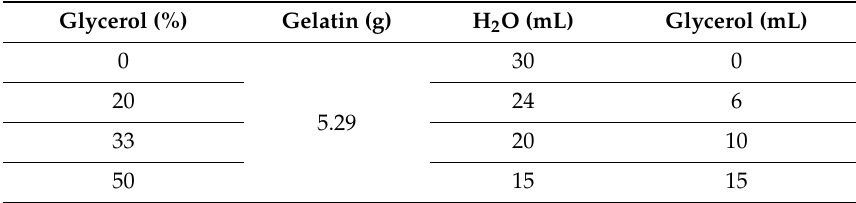
Table 2. Gelatin organohydrogels with di ff erent solvent